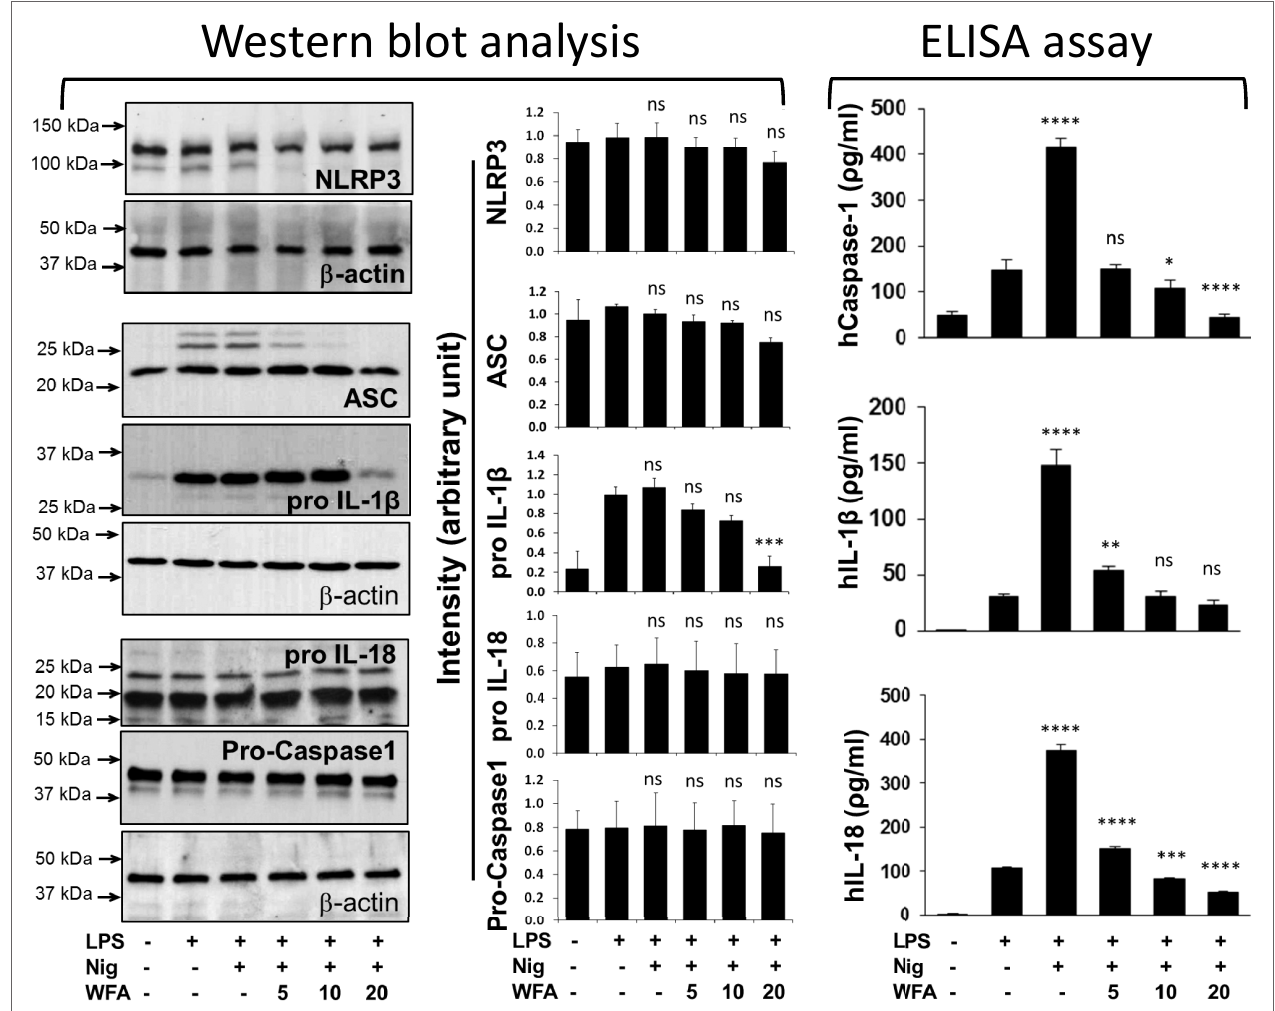
FigUre 4 | Effects of withaferin A (WFA) on proteins of the NLRP3 inflammasome complex and its downstream targets following nigericin stimulation of THP-1 cells. WFA inhibits the production of IL-18, interleukin-1 beta (IL-1 β ), and caspase-1, in a dose-dependent manner. Lipopolysaccharide (LPS)-primed THP-1 cells (5 × 10 5 cells) were stimulated with nigericin (10 µM) for 30 min. Following incubation, different doses of WFA (5, 10, 20 µM) were added for 4 h. Cellular proteins were harvested and assayed for the protein levels of NLRP3, ASC, pro-caspase-1, IL-1 β , and IL-18 by western blot analysis, while the production of active caspase-1, IL-1 β , and IL-18 in culture supernatant was determined by enzyme-linked immunosorbent assay (ELISA). For protein analysis, the blots were hybridized multiple times with different target antibody. The density of each band of a specific protein (NLRP3, ASC, pro-caspase-1, pro IL-18, and pro IL-1 β ) was divided by the density of the β -actin band for that specific membrane. Statistical comparisons were performed with the relative density to determine statistical differences using one-way analysis of variance (ANOVA), and the significant levels are shown as compared with LPS treatment (control). The data represent mean ± SE from three independent experiments. ELISA results were also subjected to one-way ANOVA, and the significant levels are shown as compared with LPS treatment. *Significant level; ns, non-significant.